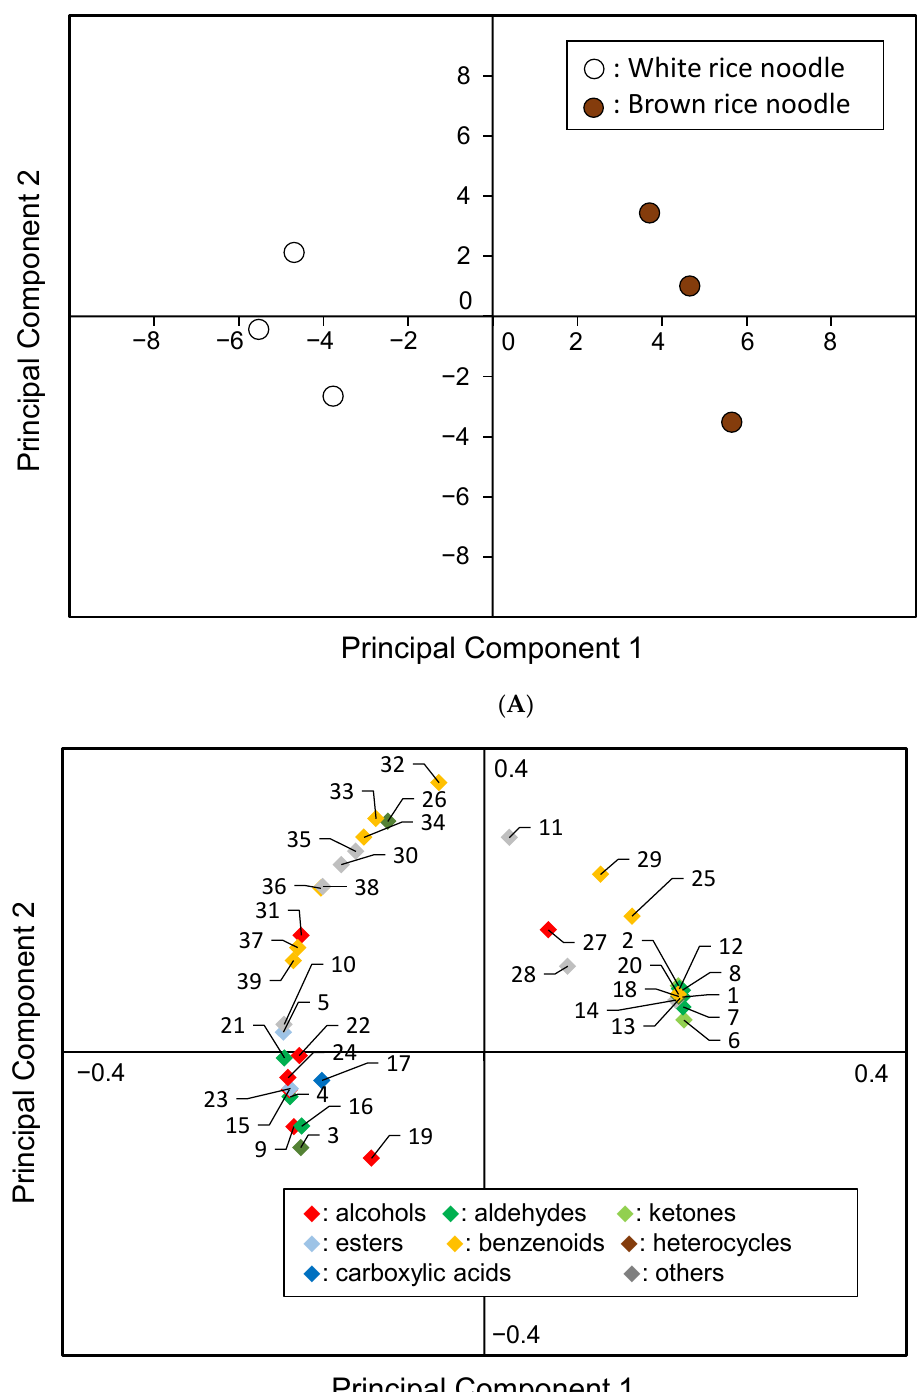
Figure 8. Results of PCA. The numbers represent the values in Table 3. ( A ) Score plot. White circles represent white rice noodles, brown circles represent brown rice noodles. ( B ) Loading plot. The score plot shows that both samples were mapped to different positions. The loading plot shows that the positions of the white rice noodles were determined by esters, such as ethyl acetate and ethyl 2-hydroxyhexanoate, alcohols, such as 2-ethyl-1-hexanol and 1-octanol, and aldehydes, such as nonanal and (E)-2-nonenal. In particular, alcohols and aldehydes have been shown to contribute to the aroma of rice [37]. On the other hand, the